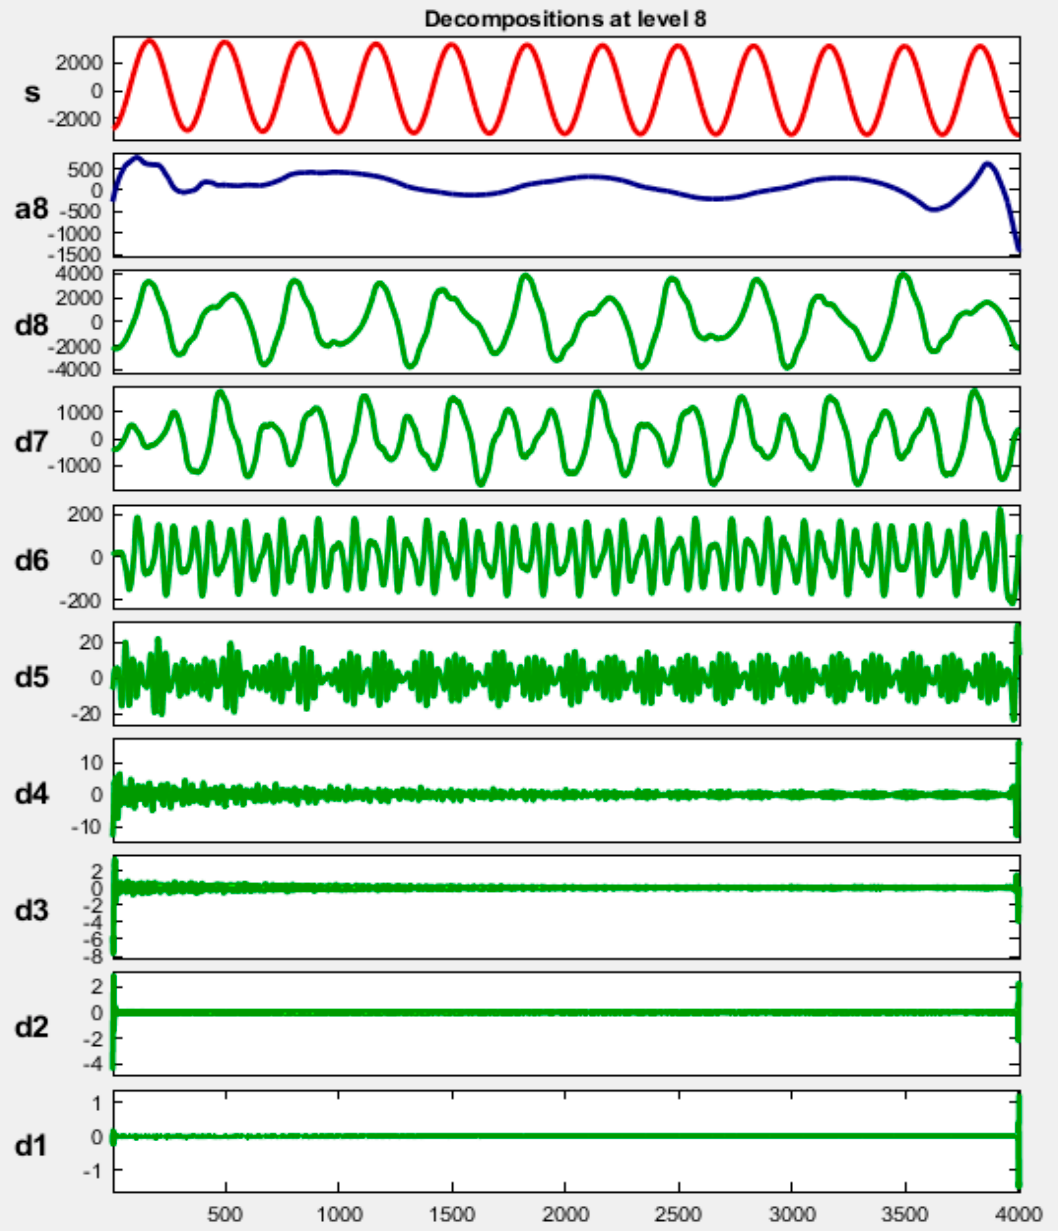
Figure 11. DWT analysis of Phase A under normal conditions with STATCOM compensation.